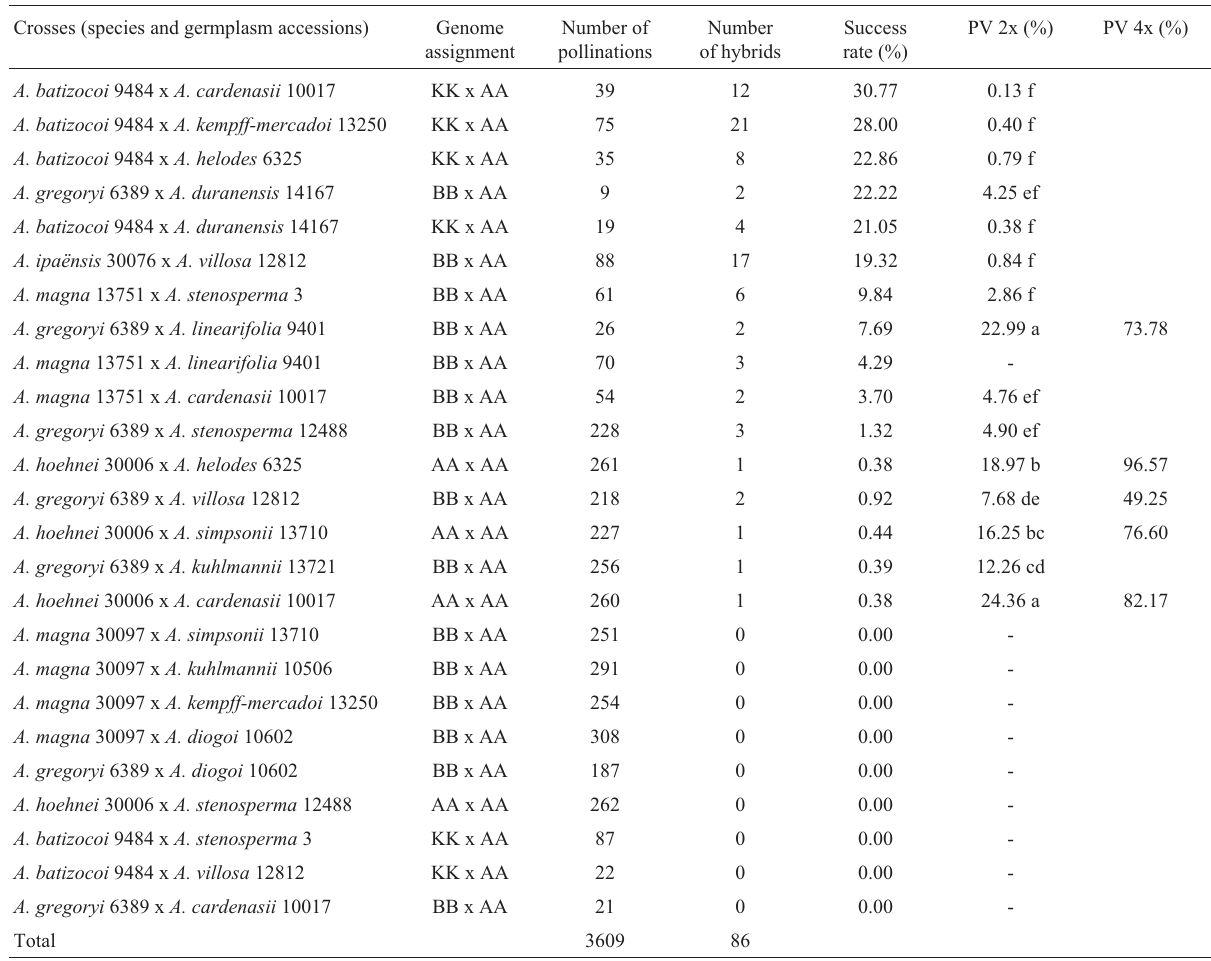
Table 1 - Genome assignment of the parents, Number of pollinations, number of hybrids, success rate, and pollen viability in diploid (PV 2x %) and tetraploid (PV 4x %) conditions for each combination of accessions of diploid species of Arachis analyzed. Crosses (species and germplasm accessions) Genome